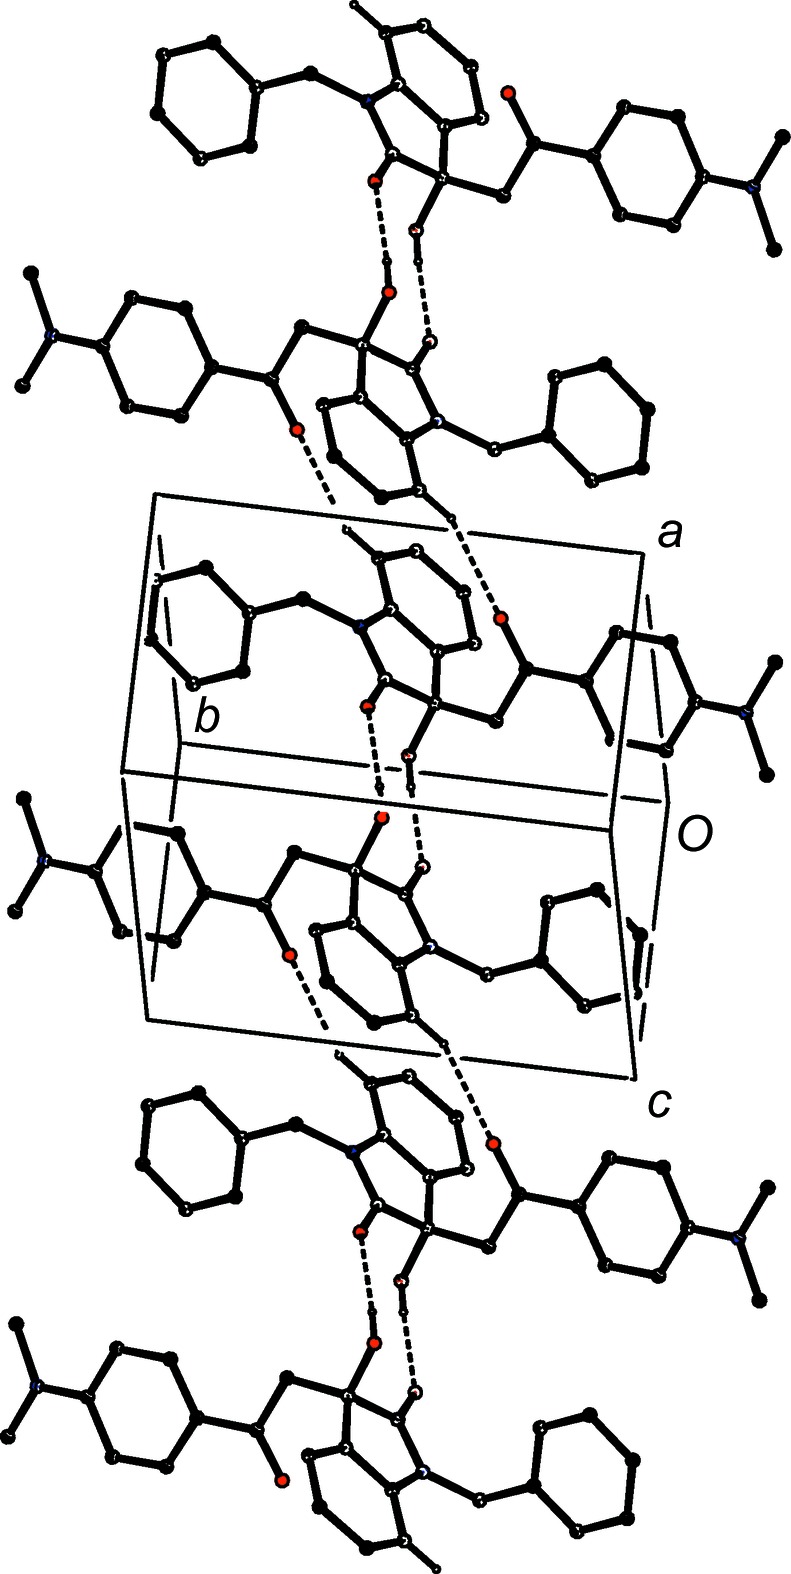
Part of the crystal structure of com­pound (Id), showing the formation of a chain of rings built from O—H⋯O and C—H⋯O hydrogen bonds. Hydrogen bonds are drawn as dashed lines and, for the sake of clarity, H atoms not involved in the motifs shown have been omitted.